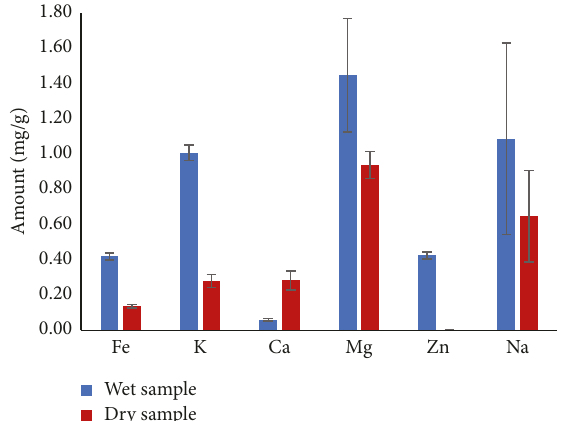
Figure 3: The content of all minerals in wet and dry extracts of W. globosa